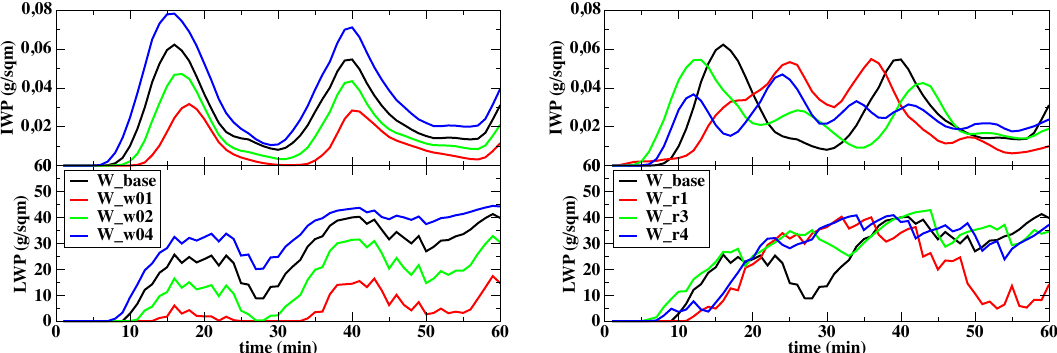
Figure 12. Liquid (lower panels) and ice water paths (upper panels) for case 1. Comparison of the different values for w ave (left) and the different stochastic realizations